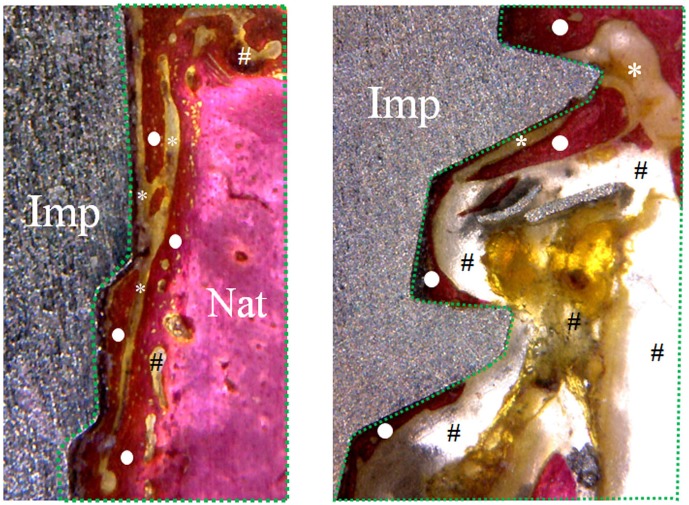
Representative images showing the area of 2 mm2 (1 mm from the implant towards the bone and 2 mm on the long axis of the implant) used for measure the parameters of new bone formed (●), osteoid matrix (*) and medullary spaces (#).(a) cortical portion and (b) medullary portion.